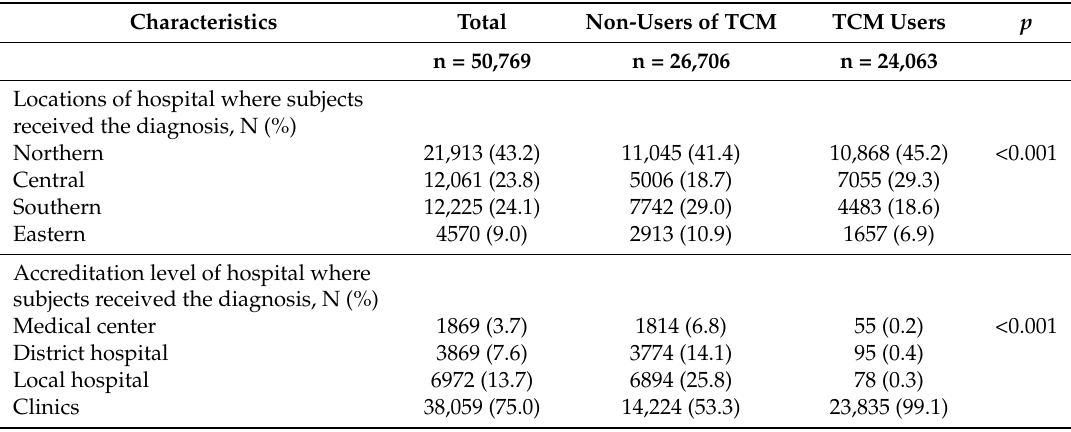
Table 2. Characteristics of hospitals where subjects received medical care at their diagnosis of dislocations, sprains and